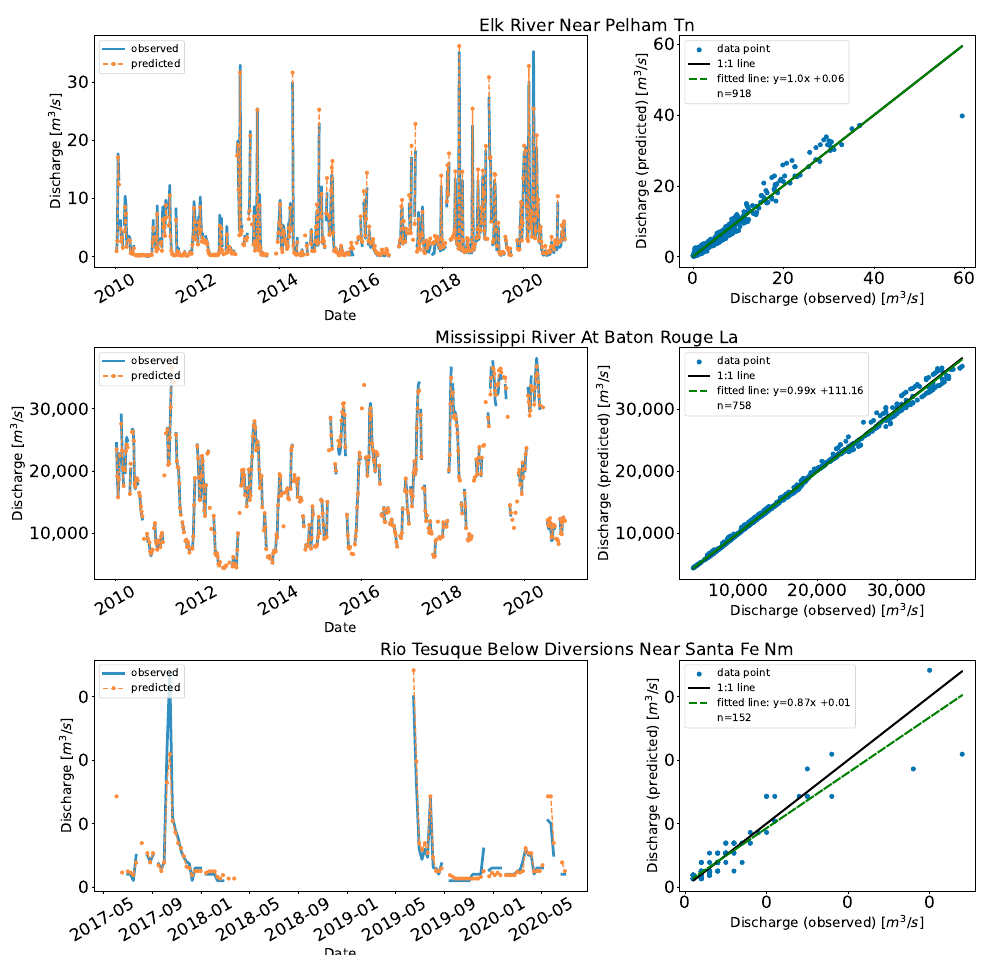
Figure 7. Predicted and observed discharge for the US with fitted and 1:1 line. For visualization purposes, in the case of a time series plot ( left side ), the data are downsampled into a weekly bin, and the mean values of the discharge failing into the bins are shown, while the scatter plot ( right side plot) shows all the validation data